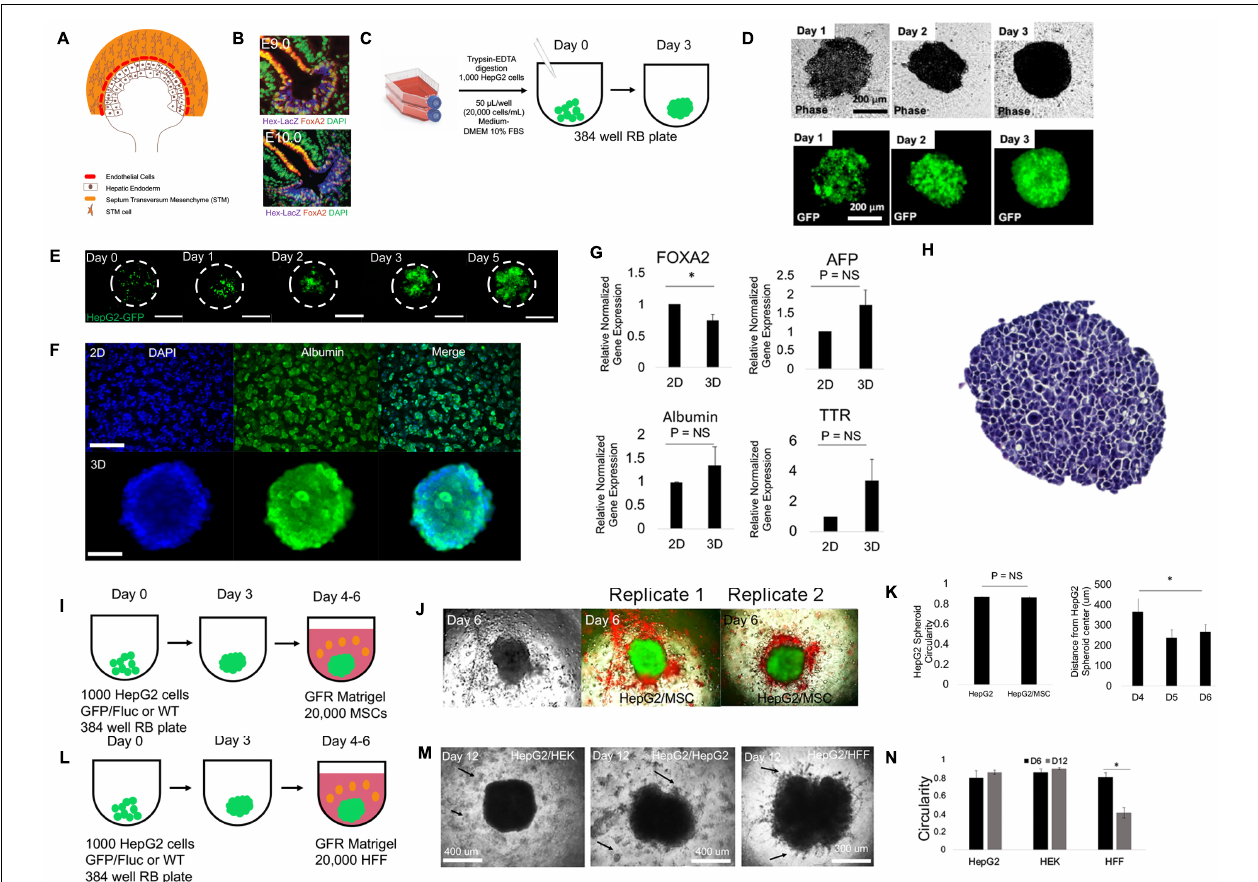
FIGURE 1 | Mesenchymal stem cells (hMSC) induce liver cell migration in 2D models but not in 3D models of the liver diverticulum (LD). (A) Schematic of LD during mouse liver development (E8.5). Shown are epithelial hepatic progenitor cells (brown), endothelial precursors (red), and the septum transversum mesenchyme (STM) (orange). At E9.5, hepatic progenitor cells together with endothelial cells, co-migrates and interacts with STM and STM cells, forming hepatic cords. (B) The LD identified in the embryological liver (E9.0, top) give rise to hepatic cords migrating (E9.5, bottom) with evidence of co-migration, branching, and interstitial migration, marked by Hex and Foxa2. Figure adopted with permission from Bort et al. (2006). (C) Schematic for making spheroid from HepG2 or HepG2-GFP cells. One thousand cells are added in 50 µ l and to a 384-well round-bottom non-adherent plate and cultured for 3 days. (D) Phase-contrast (top) and corresponding fluorescent images (below) of HepG2-GFP/Fluc from days 1–3 during spheroid formation. Bar = 200 µ m. (E) Fluorescent images of dilution experiments of HepG2-GFP/HepG2 (1:10) mixed spheroids on days 0–5 during spheroid formation. Bar = 300 µ m. (F) Fluorescent images of DAPI (nucleus) and albumin in Hep2 monolayer (top) and spheroid (bottom) culture on day 3 of culture. (G) qRT-PCR analysis of Foxa2 ( P = 0.041, n = 3), alpha-fetoproteien (AFP), albumin, and transthyretin (TTR) ( P = NS) in monolayer and day 3 spheroid culture compared with control ( n = 3). Plotted is mean ± SD. Significance defined as P ≤ 0.05. (H) Hematoxylin and eosin-stained 10 µ m section of HepG2 spheroid in suspension culture illustrates uniform epithelial morphology of 3D tissue. Bar = 200 µ m. (I) Schematic for modeling the LD. Spheroids are made as in (G) and then embedded in 20,000 MSC containing growth factor-free (GFR) MG and cultured for long term. (J) Phase (left), double fluorescent (red/green) images (right) of days 4, 5, and 6 LD models, bearing a HepG2-GFP spheroid (green) and MSC (red) in MG. Right columns of images are replicates 1 and 2 with double fluorescent images on days 4, 5, and 6. Bar = 500 µ m. (K) Bar graph plotting spheroid circularity (left) of HepG2 and HepG2/MSC spheroids ( P = NS; n = 3) and (MSC) distance from HepG2 spheroid on days 4, 5, and 6. days 4 to 6 compared ( P = 0.00043; n = 3). Plotted is mean ± SD. (L) Schematic for modeling the LD. HepG2 spheroids are embedded in 20,000 human foreskin fibroblasts (HFF) containing growth factor-free (GFR) MG and cultured for long term. (M) Phase-contrast images on day 12 of culture of negative control [HepG2 spheroid embedded with human embryonic kidney (HEK) cells (HepG2/HEK)], a negative control (HepG2/HepG2), and the experimental (HepG2/HFF) condition all at 1:1 ratio. Arrows in the HepG2/HepG2 condition and the HepG2/HEK condition specify the relative location of the HepG2 and HEK cells seeded in the surrounding GFR MG. Arrows in the HFF condition specify the occurrence of co-migration of both HepG2 and HFF cells into the MG. (N) Bar graph plotting spheroid circularity in HepG2/HepG2, HepG2/HEK,